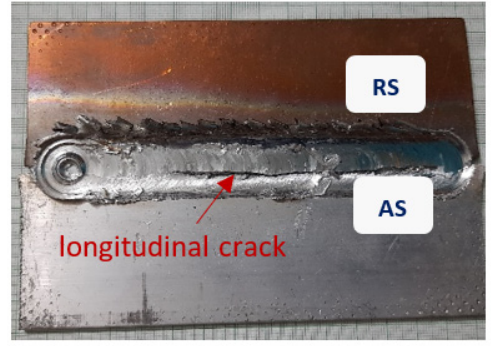
Figure 9. FSW weld joint with Cu (RS) and Al.